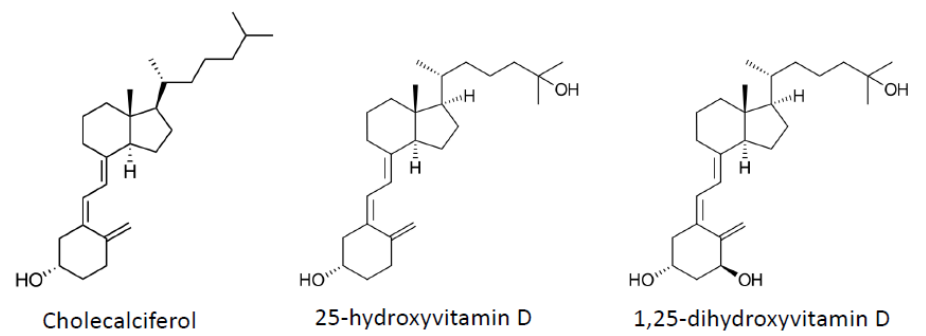
Figure 2. Vitamin D and metabolite